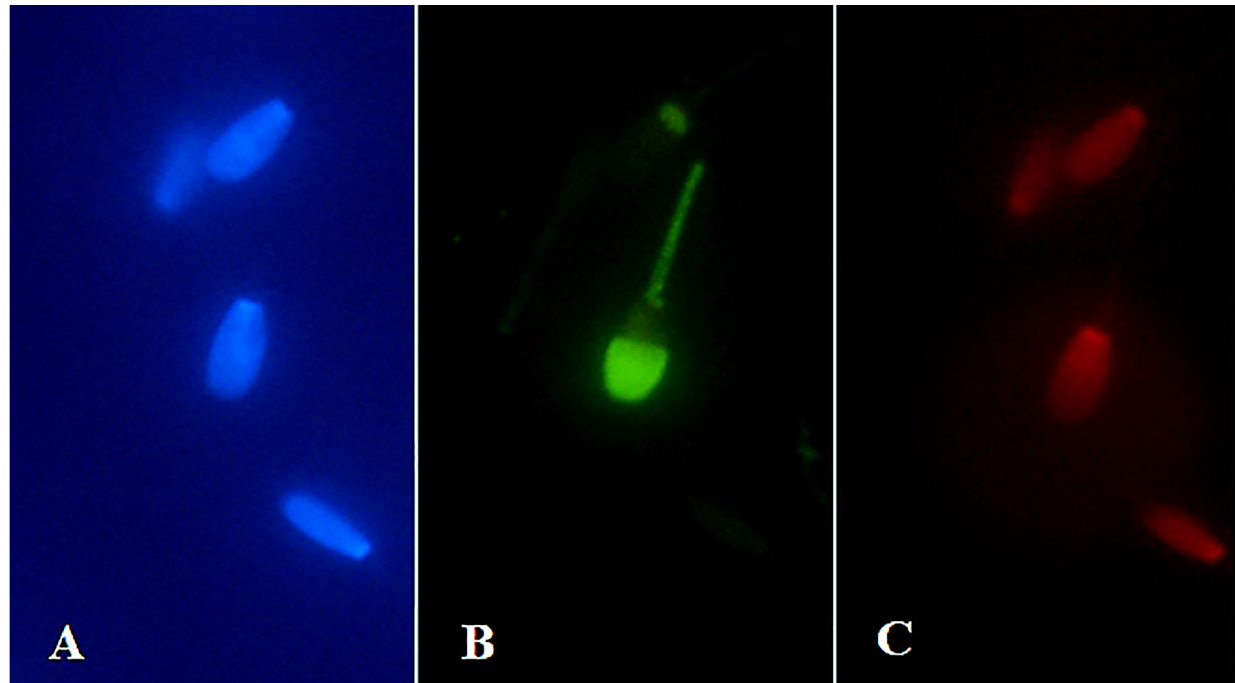
Fig 6. More detailed image of altered spermatozoa in the group with the highest concentration (1000 μ M) of FeSO 4 .7H 2 O and the longest time of exposure (6 h). Blue-stained (DAPI positive) chromatin of spermatozoa heads (A). Annexin-positive regions of apoptotic changes (B) were found not only in the mitochondrial portion, but also on the spermatozoa head (acrosomal part). Necrosis positivity by propidium iodide at the excitation 488 nm was detected (C) (400x